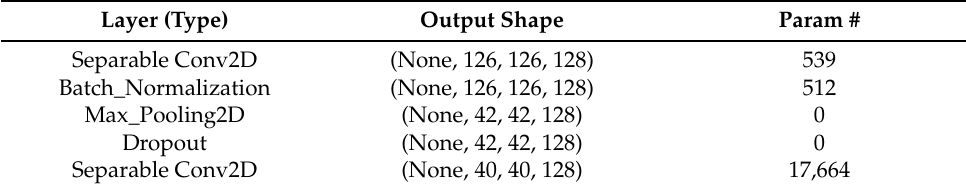
Figure 3. 5-layer(v1) network architecture diagram. Table 3. 5-Layers (v2) network